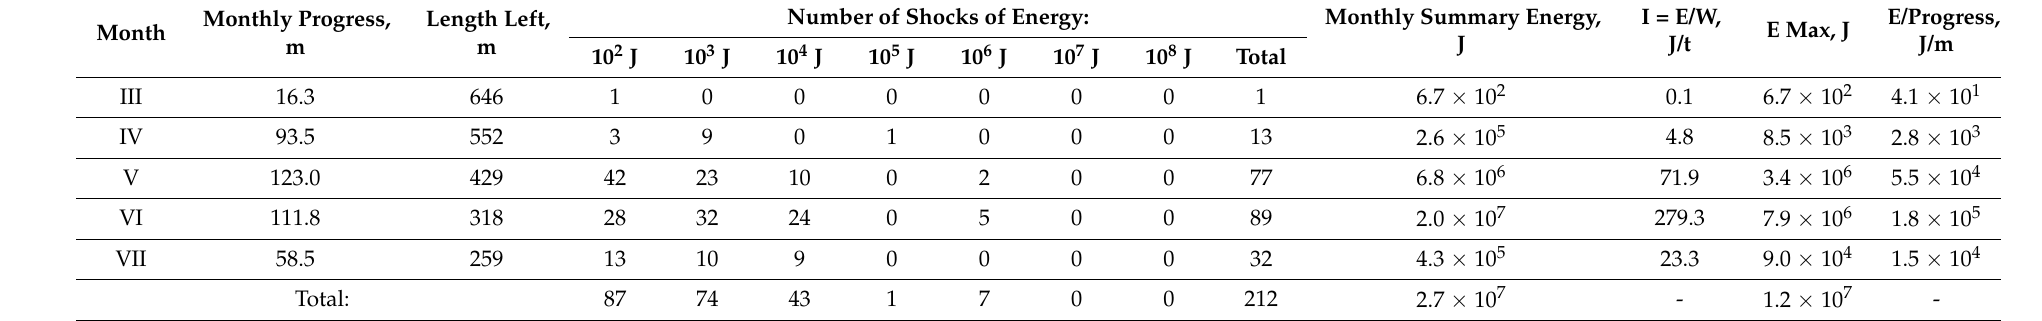
Table 2. Shocks registered during the exploitation of seam 713/1-2 at longwall II-E1 until July 9th 2017 (until the first hydraulic